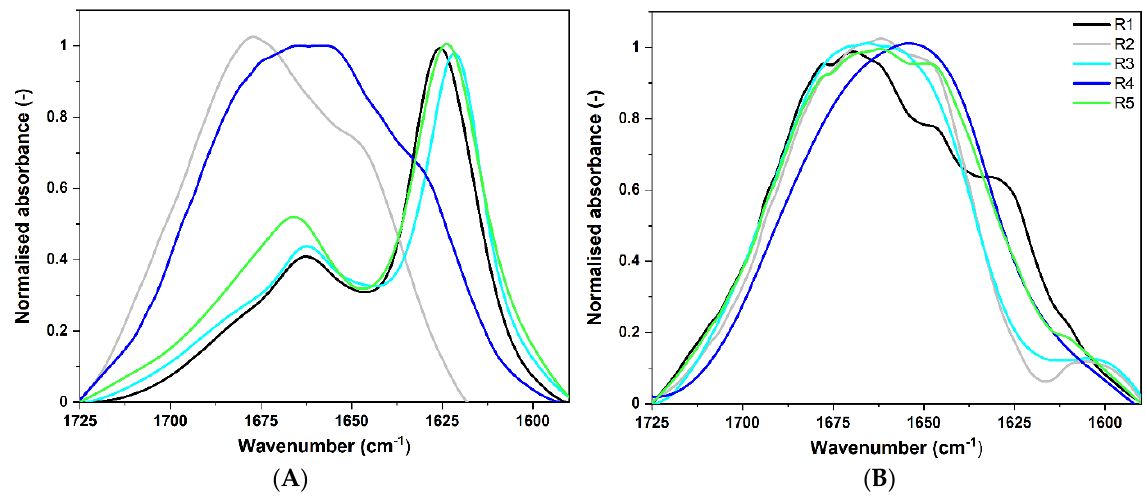
Figure 3. Normalized ATR-FTIR spectra of E. coli fragments in the wavenumber range of 1725–1590 cm −1 (Amide I), smoothed SG 35 (see Methods). ( A ) on the day of the dissolving ( B ) after one month of incubation at 37 °C. Peptide concentration was 500 µM.